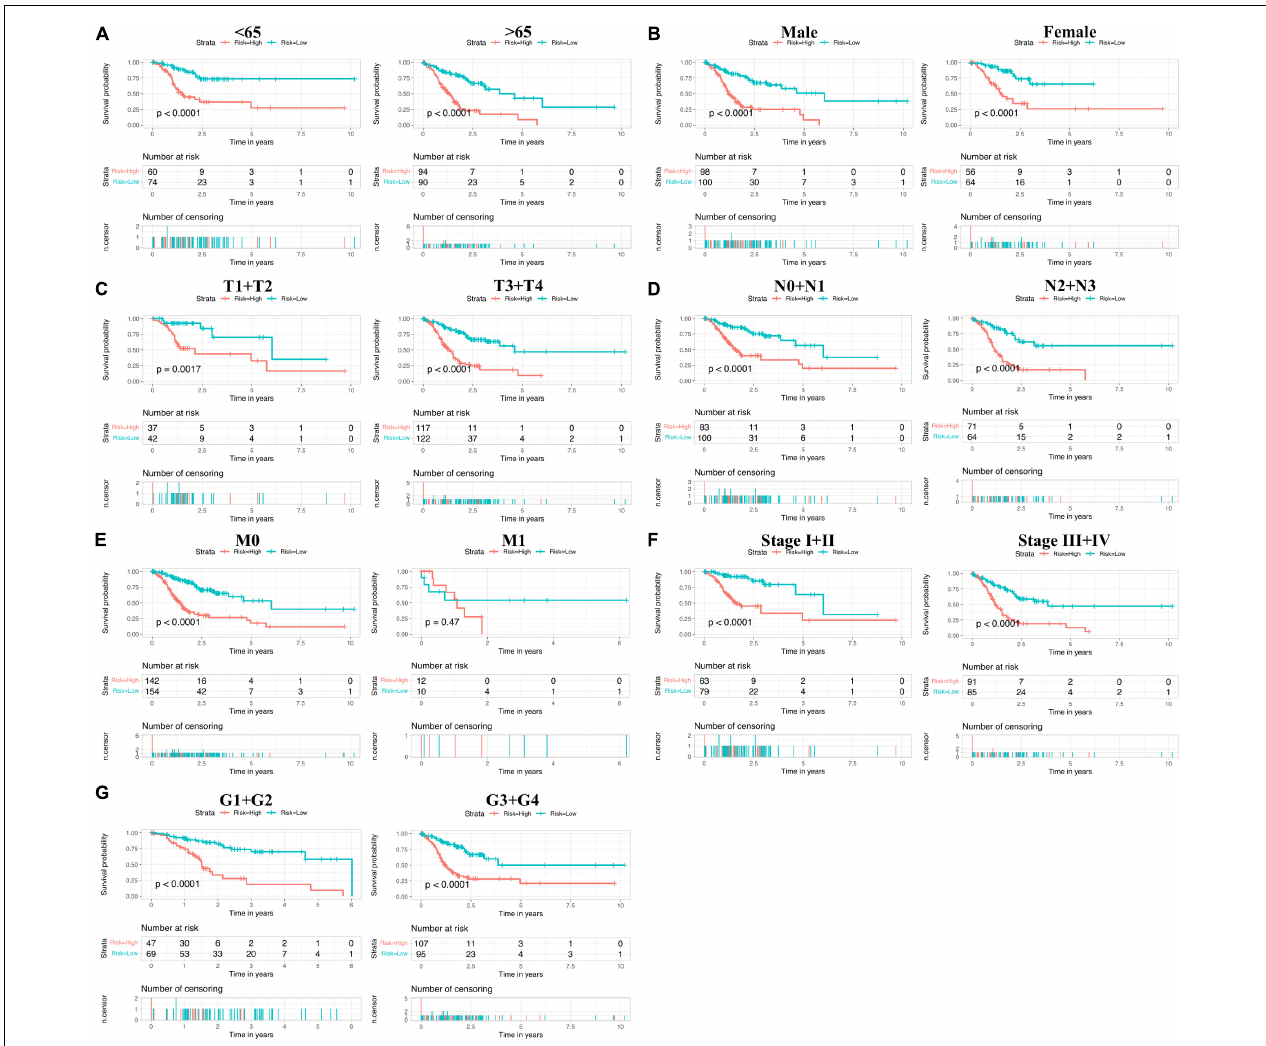
FIGURE 6 | Subset group Kaplan–Meier (K-M) survival curves of patients. (A) Age < 65 years ( left ) and ≥ 65 years ( right ). (B) Males ( left ) and females ( right ). (C) T1+T2 ( left ) and T3+T4 ( right ). (D) N0+N1 ( left ) and N2+N3 ( right ). (E) M0 ( left ) and M1 ( right ). (F) Stage I+II ( left ) and stage III+IV ( right ). (G) G1+G2 ( left ) and G3+G4 ( right